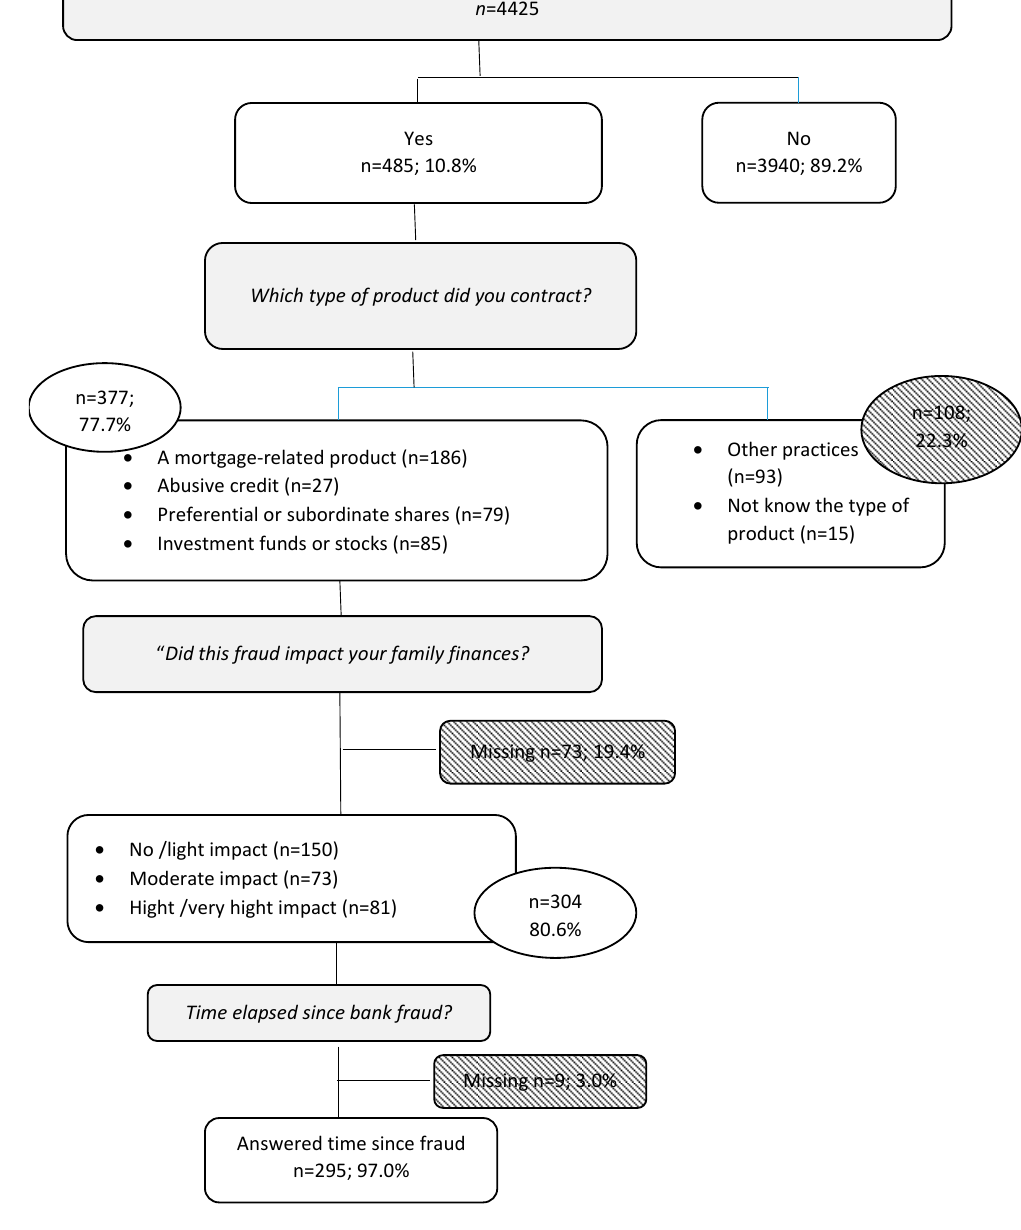
Figure 1. Sample definition, Madrid Health Survey 2017.